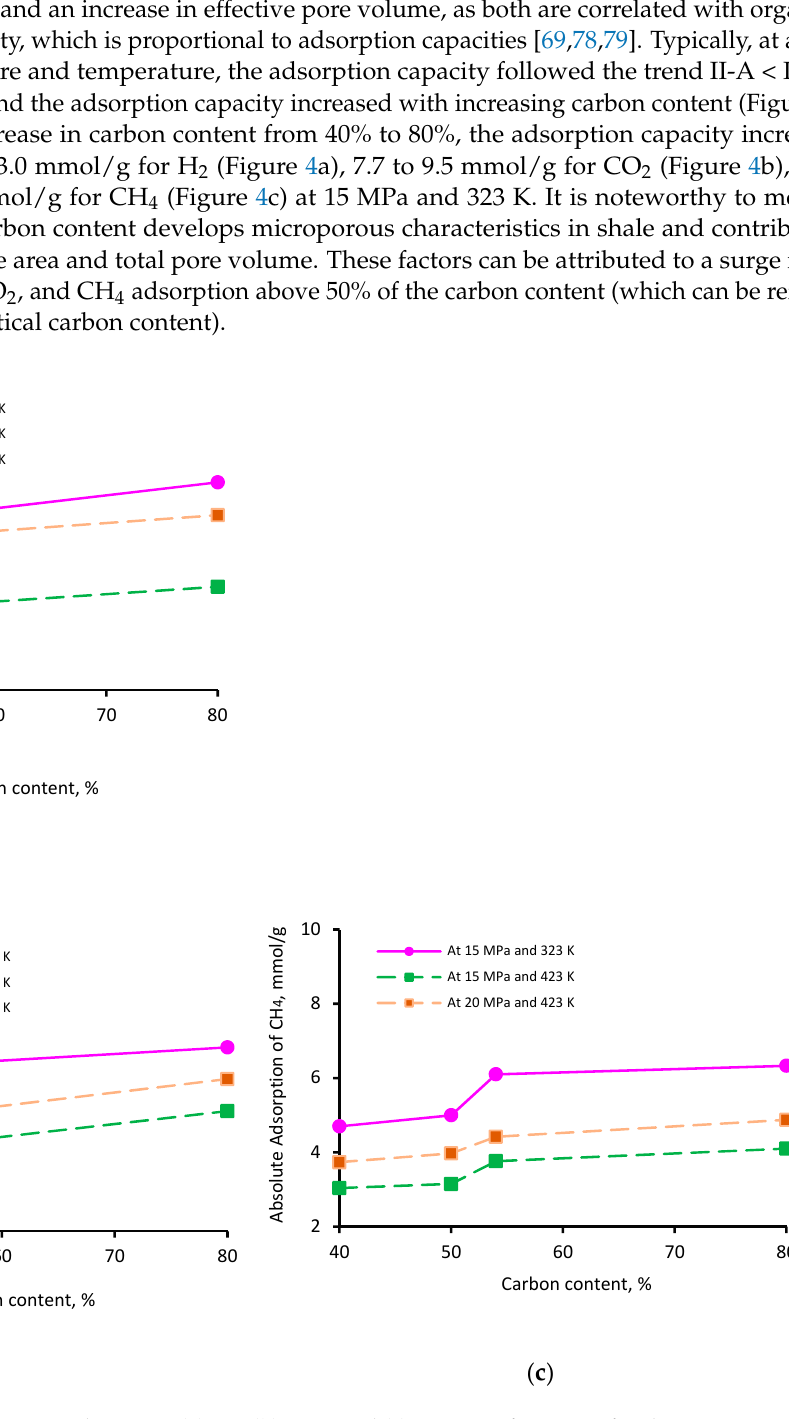
Figure 4. Gas adsorption ( a ) H 2 , ( b ) CO 2 , and ( c ) CH 4 as a function of carbon content.